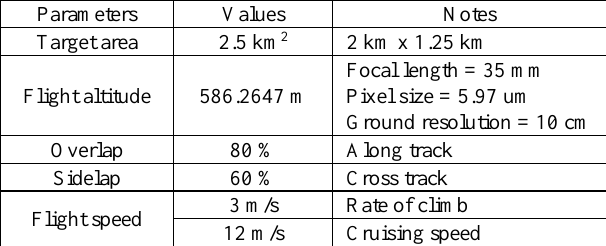
Table 3. Main simulation parameters